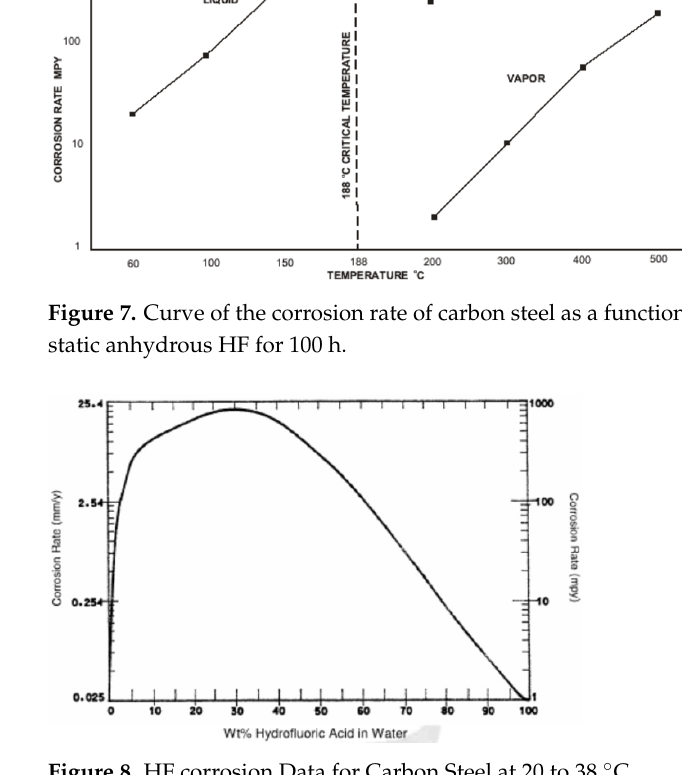
Table 4. Corrosion rates of carbon steel and Monel alloy at different temperatures and concentrations.